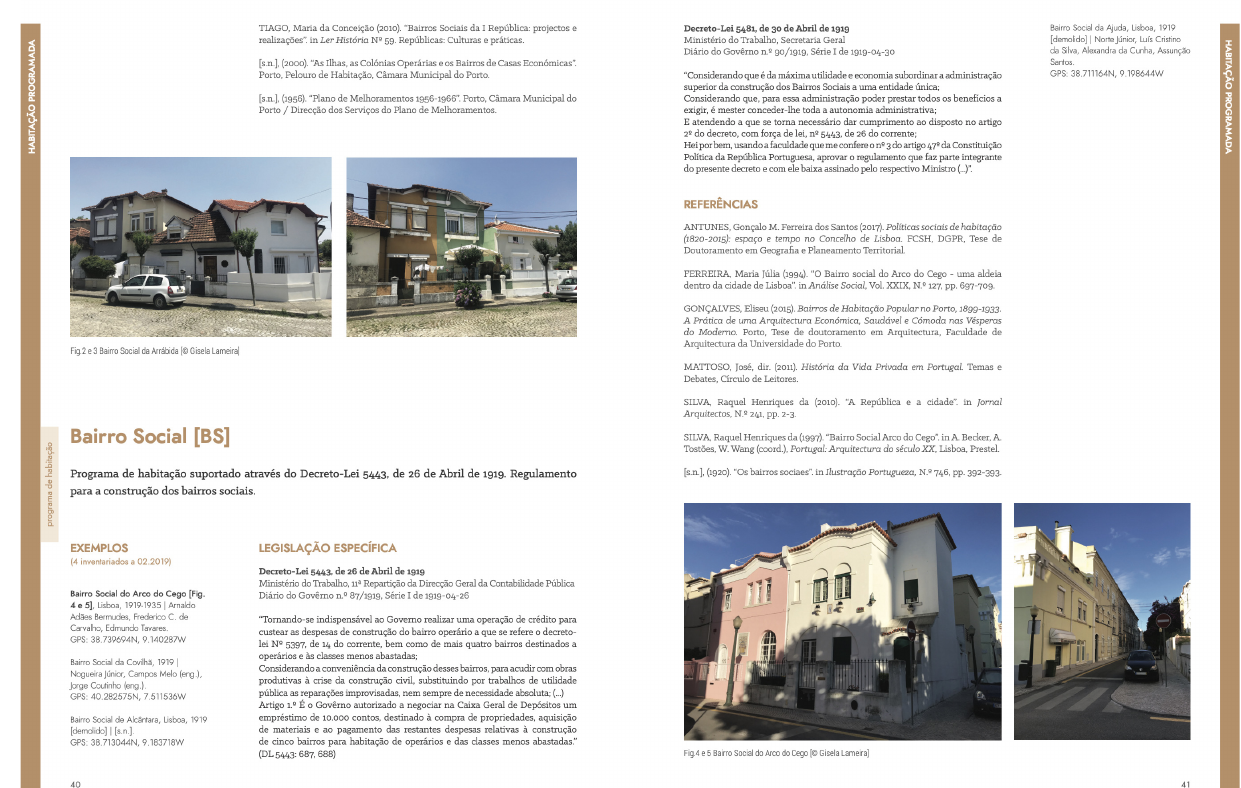
Figure 3. Social Housing District (Bairro Social), 1919. Notes: This double‐page spread represents the Bairro Social do Arco do Cego , Lisbon, 1919–1935, which was completed during the Estado Novo regime (reference a216 in MdH database). In these pages, we can also find information about the specific regulation that gave rise to this housing programme and some bibliographical references. Source: Lameira and Rocha (2019, pp. 40–41).